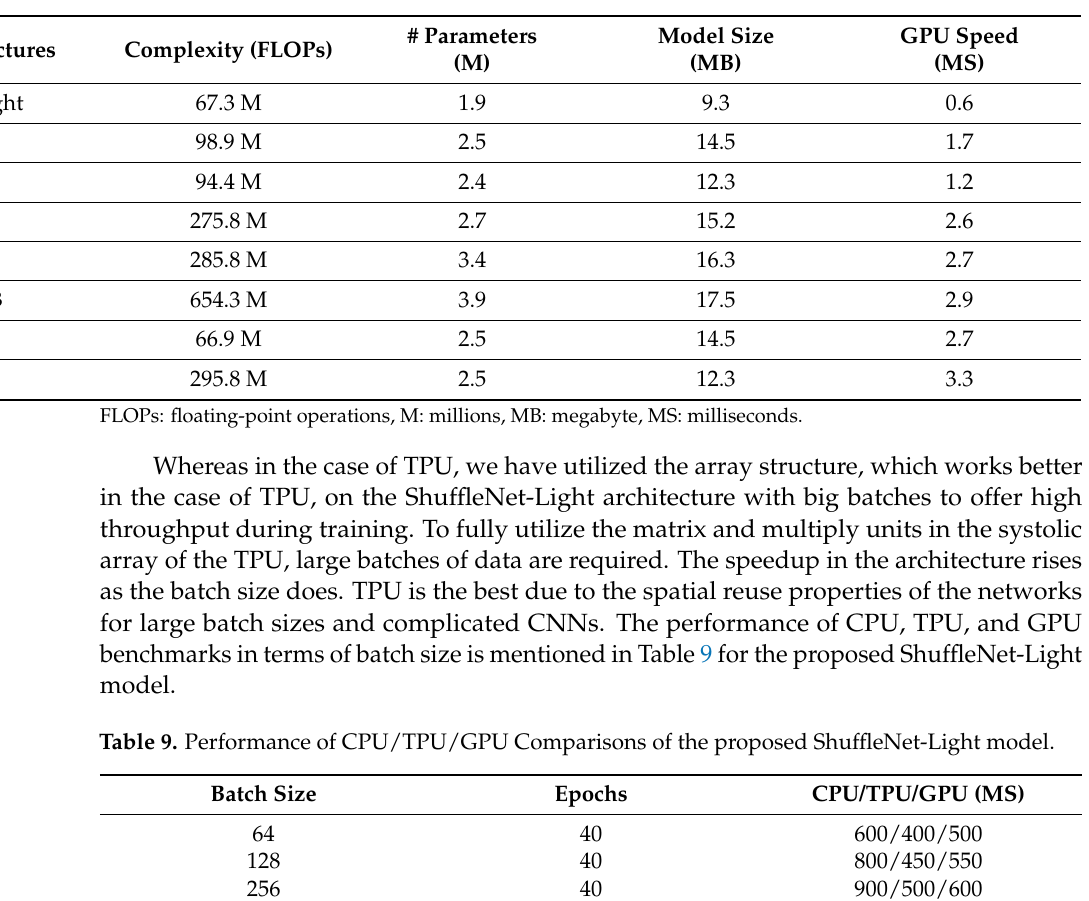
Table 8. Computational performance of state-of-the-art seven classes. Experiments were performed on three datasets such as the ISIC-2019, ISIC-2020 and HAM10000.